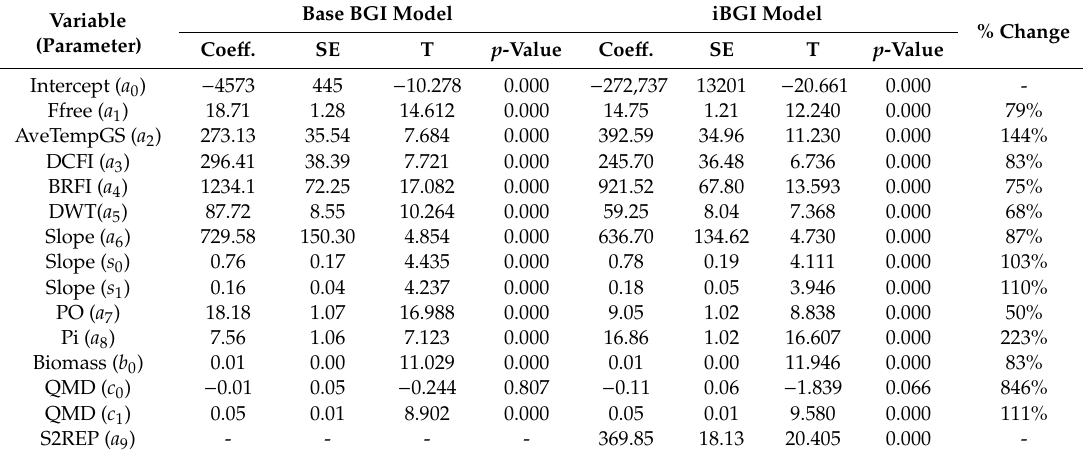
Table7. BiomassgrowthmodelvariablesandnonlinearmodelparameterestimatesforEquations(1)–(7). Variable